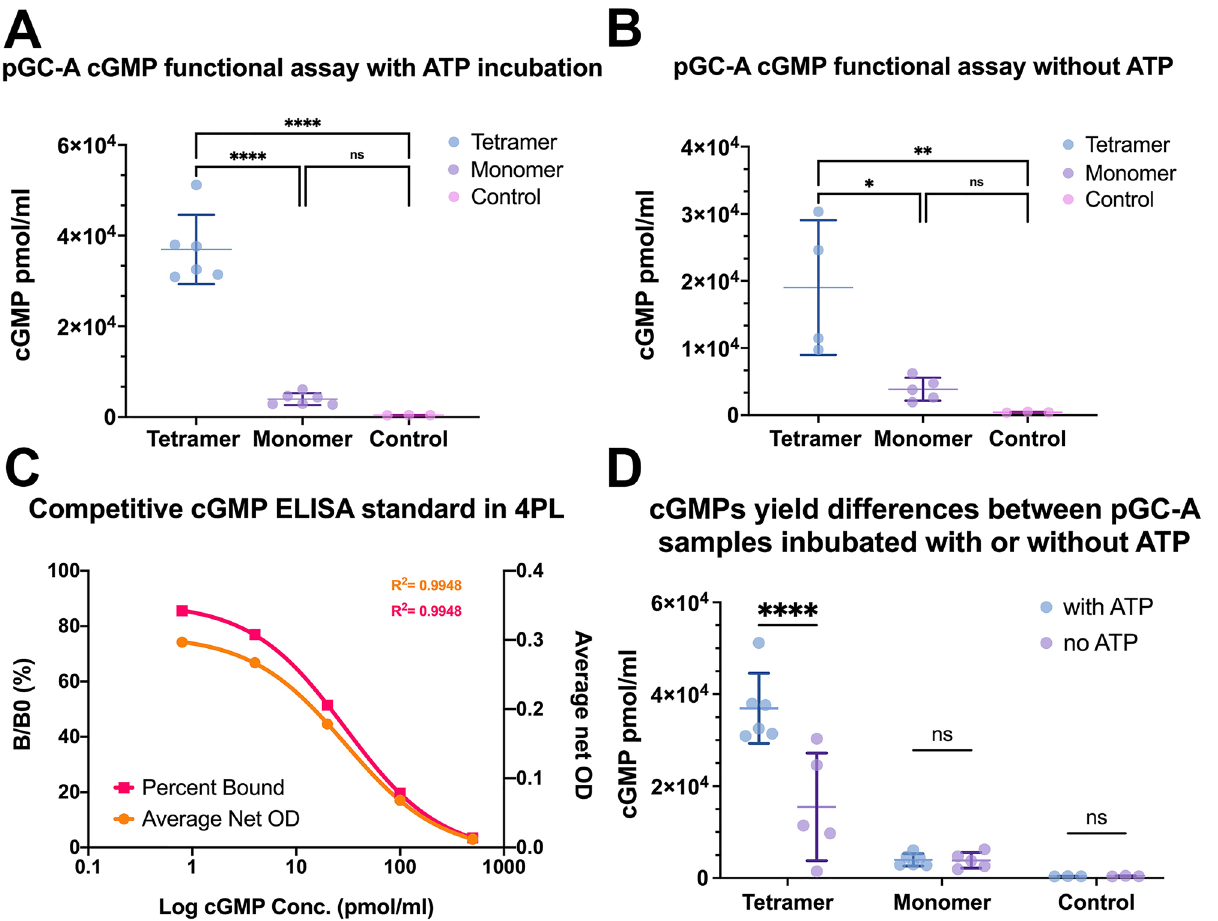
Figure 10. Purified full-length pGC-A in vitro functional activity test. ( A ) Functional activity for two pGC-A oligomeric states with ATP incubation. The control group was GTP and ATP in sample buffer. For activity values in units of mg of purified pGC-A, the y-axis values of pmol/mL can be converted to nmol/mg protein by multiplying by 0.00873. ( B ) Functional activity for two pGC-A oligomeric states without ATP incubation. The control group was GTP only in the sample buffer. ( C ) Competitive cGMP ELISA standard fit in four parameters logistic (4PL) curve. The left Y-axis is the B/B0 (%) value and represents the percentage of bound cGMP. The right Y-axis represents the average net optical density (OD) reading at 405 nm. Both standard curves were generated with a 95% confidence interval. ( D ) The cGMP yield differences between pGC-A oligomer samples incubated with or without ATP were analyzed. All raw data points were analyzed via the ROUT method (Q = 1%) to remove significantly impossible outlier values before data analysis. One-way ANOVA was used to determine the statistical significance between samples and control in graphs ( A ) and ( B ). Two-way ANOVA was used to determine the statistical significance in graph ( D ). Each dot represented to the sample point and plotted as mean ± standard deviation (SD). * P ≤ 0.05, ** P ≤ 0.01, **** P ≤ 0.0001 and ns P ≥ 0.05, Not Currently, there is available only the rat pGC-A extracellular domain structure with and without ligand ANP information 22–24 . To maximize the functional protein expression in Sf9 insect cells, we replaced the original N-terminal signal peptide with a cleavable signal peptide from influenza hemagglutinin 45 . This is the same strat- egy used in most G-protein-coupled receptor (GPCR) expressions in insect cells for structure determination 46,47 . Although the signal peptide was switched to the highly expressing influenza hemagglutinin, and the pGC-A DNA sequence was optimized for protein expression, the yield of functional human full-length pGC-A was quite low. The low yield may be due to protein characteristics. A previous study that expressed rat full-length pGC-A in baculovirus Sf9 insect cells reported similar modest protein production 40 . Protein sequence BLAST analysis shows that the full-length human pGC-A (UniProtKB/Swiss-Prot accession no. P16066.1) is 91.38% identical to rat pGC-A (GenBank access. no. XP_032753748.1). Higher oligomerization of full-length pGC-A was reported in both its native expression source and recom- binant expression in a mammalian cell line 27,28 . The human full-length pGC-A expressed in human embryonic kidney cell line 293 (HEK293) showed full-length pGC-A is self-associated to a possible tetrameric complex prior to ANP binding, and the truncation experiment indicates that the intracellular domain of pGC-A is nec- essary for self-association 28 . The partially purified full-length pGC-A from bovine adrenal cortex membranes indicates that the bovine full-length pGC-A is a disulfide linked tetramer 27 . Protein sequence BLAST shows that